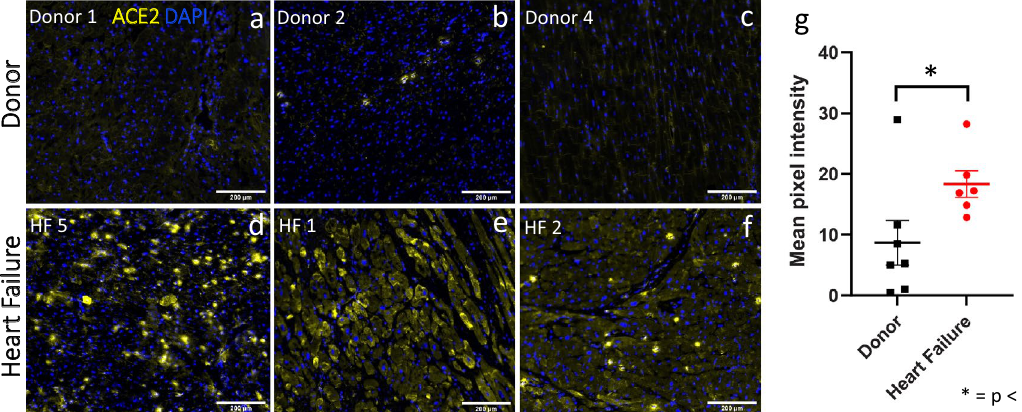
Figure 3. Protein expression of ACE2 by Immunohistochemistry (IHC). (a-c) Representative images of IHC staining of tissue sections from three organ donors showing no or few ACE2-expressing cells. (d-e) Representative images from three HF patients showing ACE2-expressing cells. (g ) Measurement of mean pixel intensity show that heart failure group had a significant higher ACE2 staining intensity compared to the donor group ( p = 0.035).